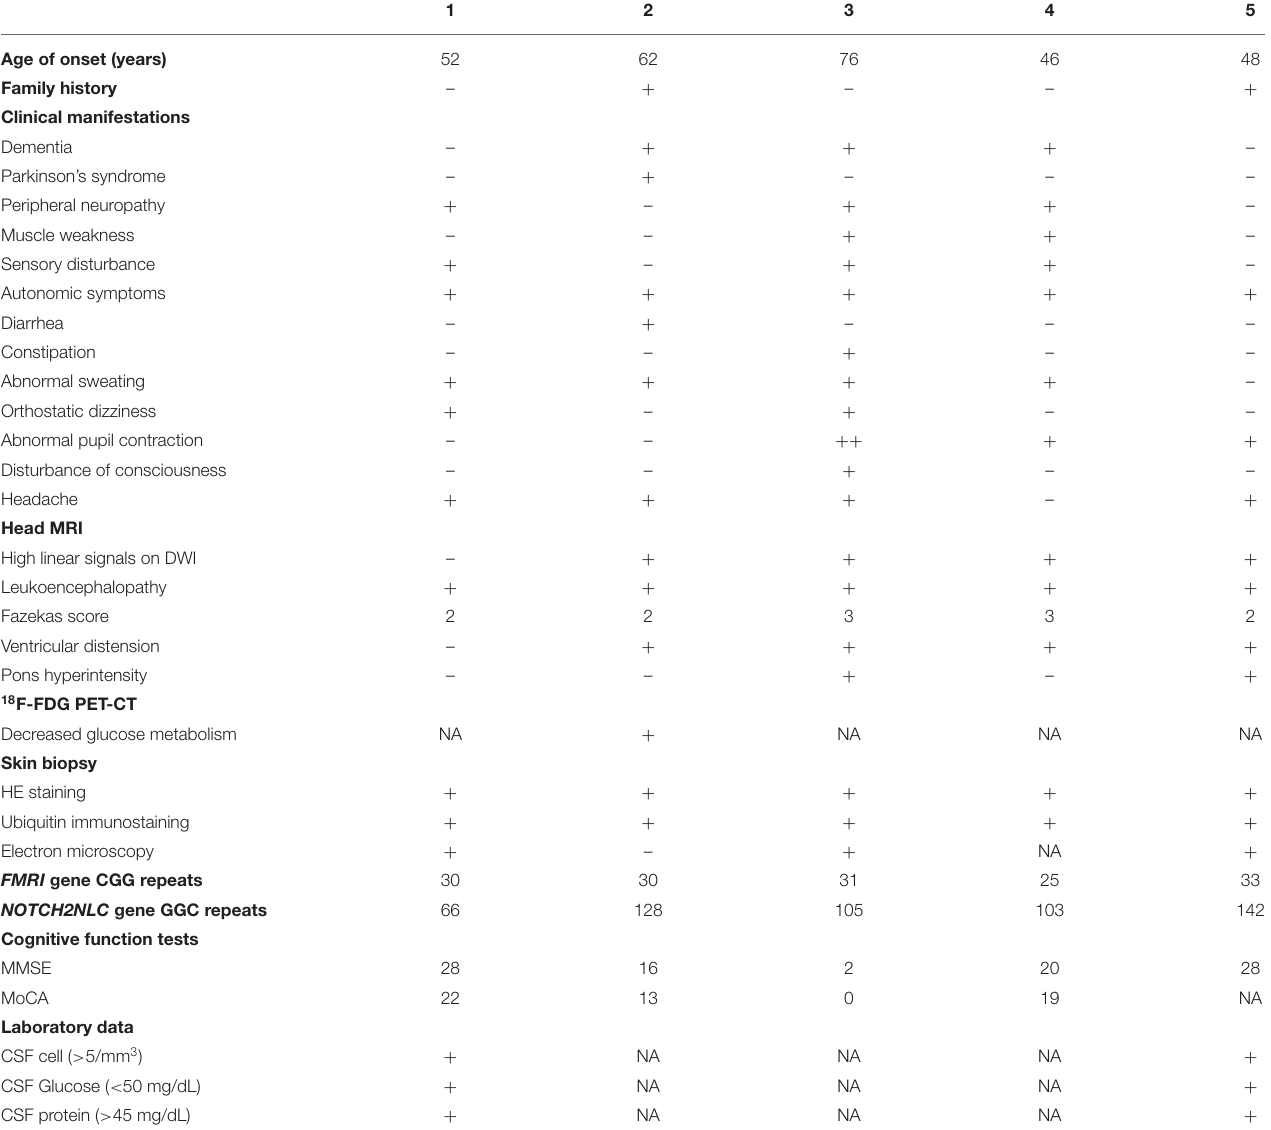
TABLE 1 | Demographic and clinical data of patients with